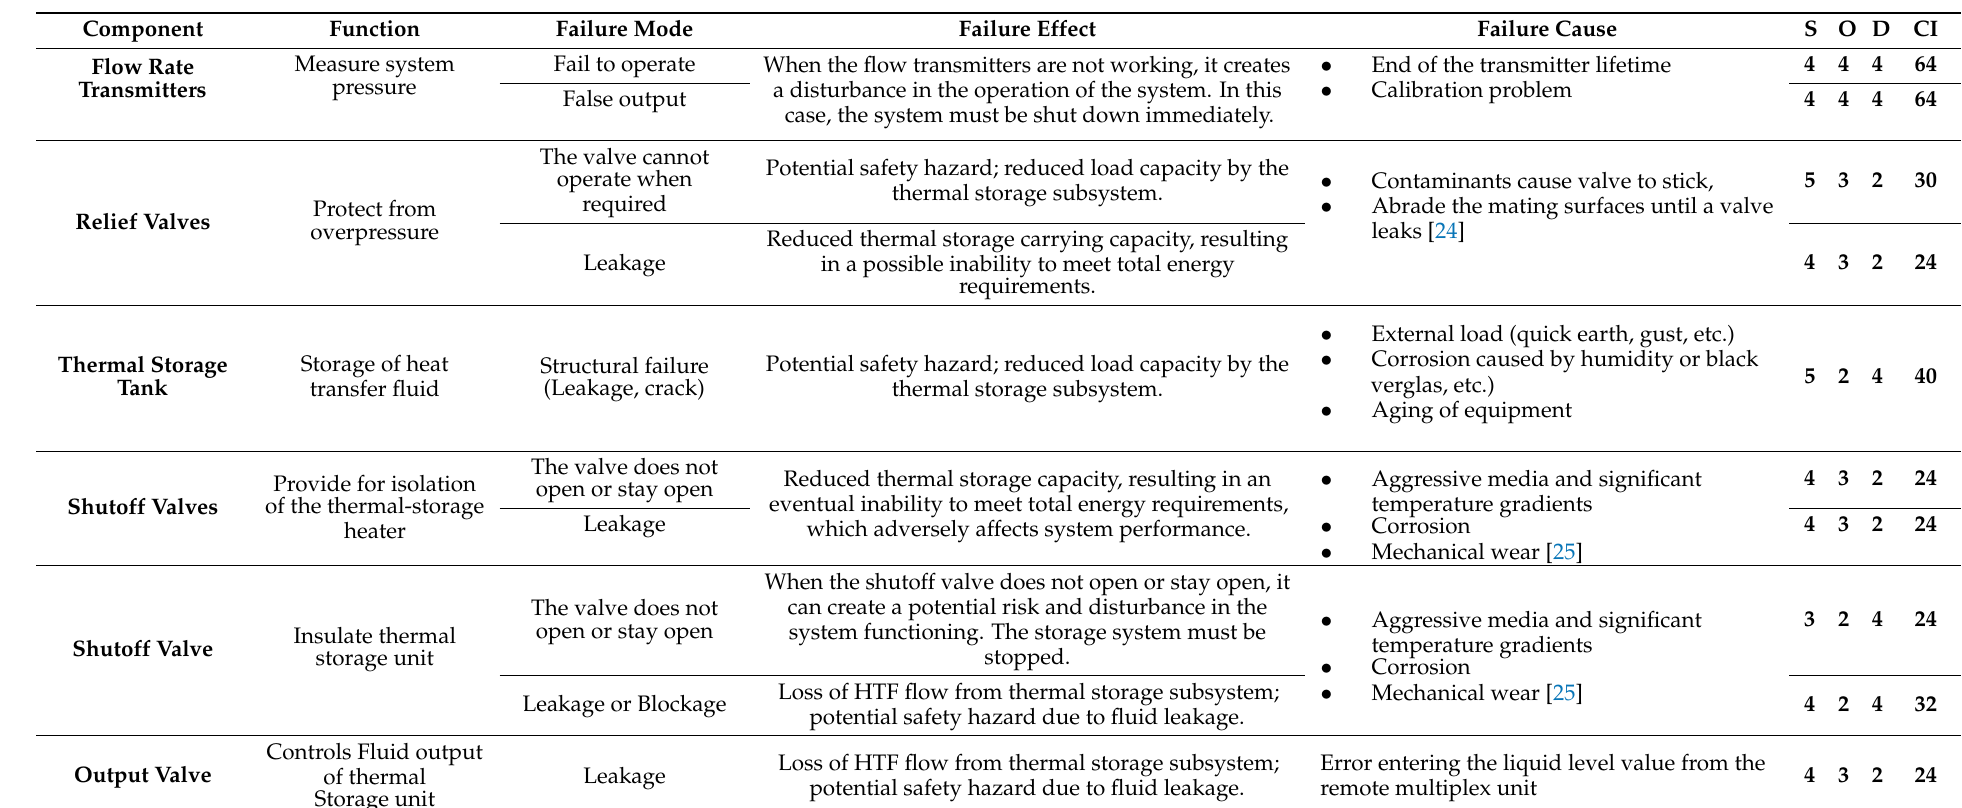
Table 3. Thermal Storage Subsystem